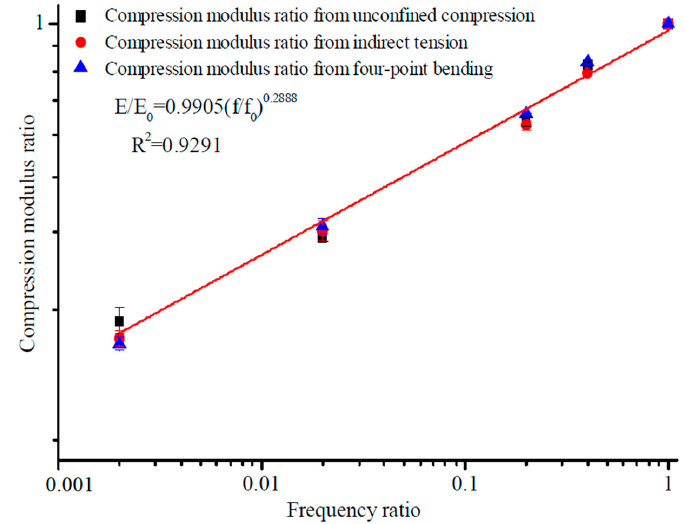
Figure 7. Standardized variation patterns for compression modulus ratio with frequency ratio.